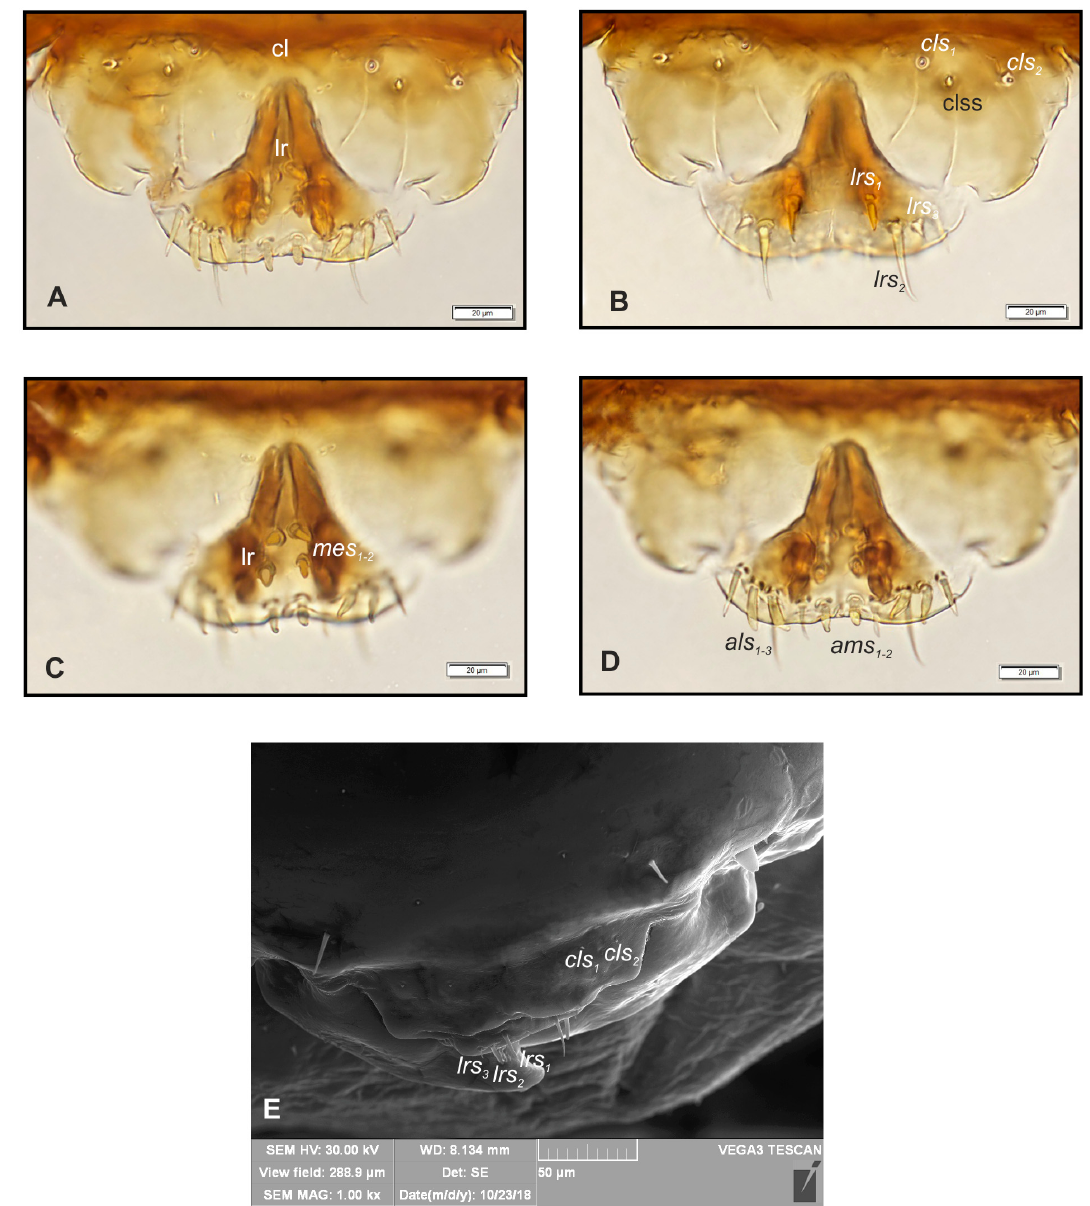
Figure 4. Bagous claudicans mature larva, clypeus, labrum and epipharynx. ( A )—clypeus and labrum general view; ( B )—clypeus and labrum (focused on dorsal surface); ( C , D )—clypeus and labrum (focused on ventral surface); ( E )—clypeus and labrum, SEM photography (clss—clypeal sensorium, lr—labral rods, setae: als —anterolateral, ams —anteromedial, cls —clypeal, lrs —labral, mes —median).